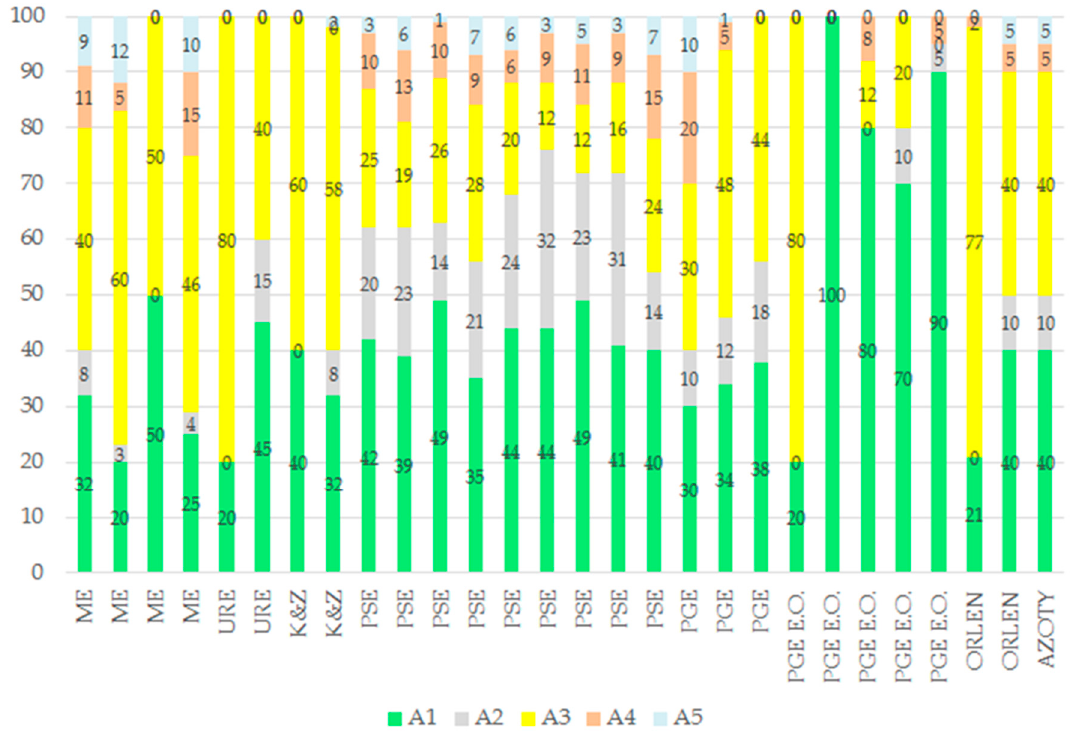
Figure 2. Survey results—the general section (impact of the power market on a given area of the electric energy sector).